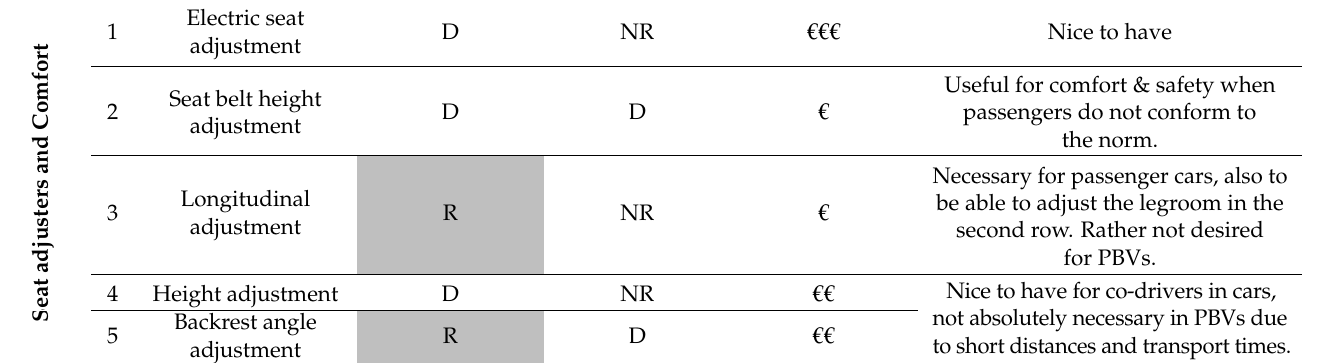
The requirements for adjusters and comfort functions differ considerably between passenger cars and PBVs. Only a few points are